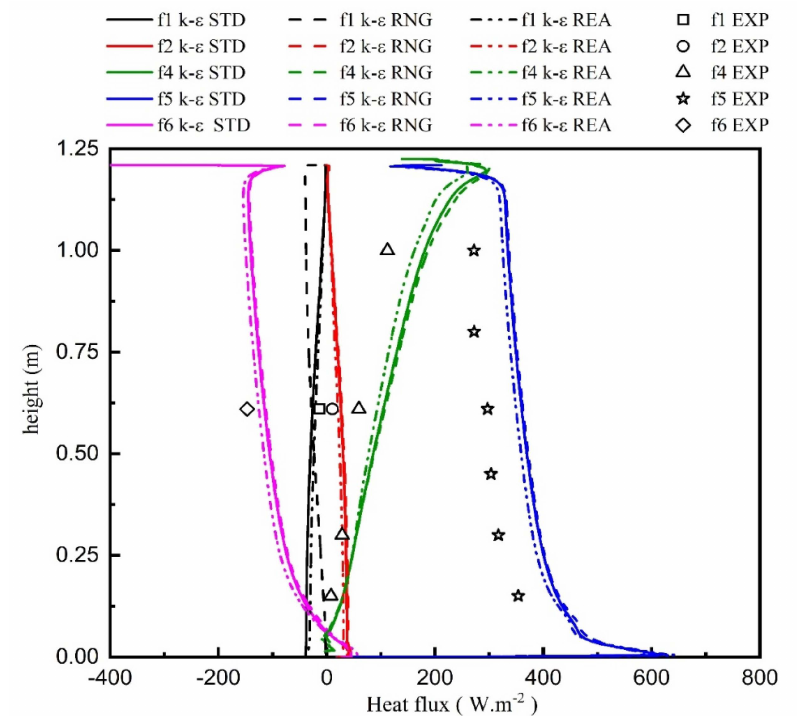
Figure 10. Experimental and numerical heat fluxes for the three glazings, according to k- ε models with a standard wall function.